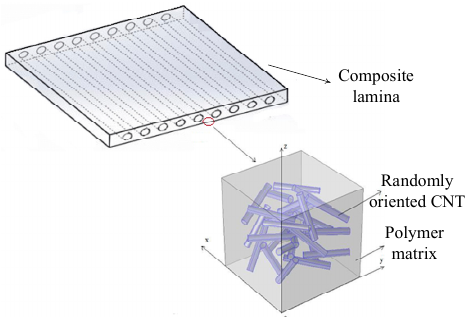
Figure 1. Schematic illustration of a unidirectional fiber-reinforced composite lamina, with the inclusion of CNTs in the polymer matrix. CNTs are considered as randomly oriented.